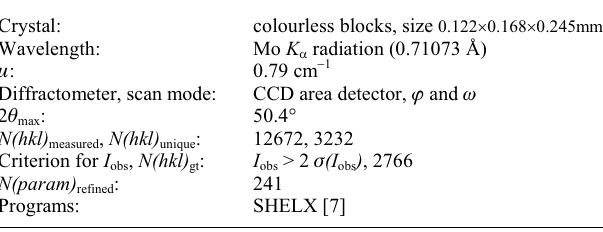
Table 1. Data collection and handling.